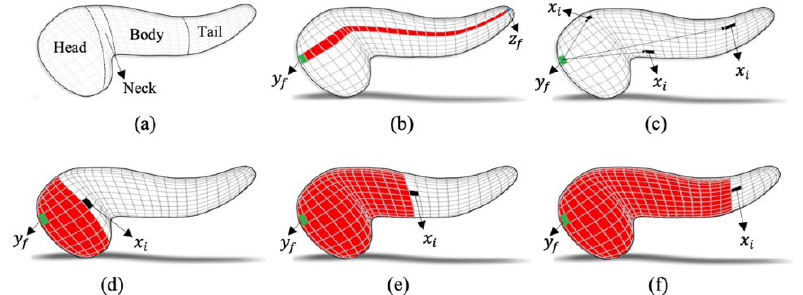
Figure 1. ( a ): Pancreas structure with head, neck, body, and tail region in a 3D mesh. ( b ): Length of the pancreas is shown as the shortest Euclidian distance (in red) between y f (in green) and the pixel farthest from it (in blue). ( c ): three examples of pixel x i (in black). For each x i , the α is the Euclidian distance between y f and x i . ( d – f ): Examples of x i considered at three different locations. For each x i , the β is the area (in red) between y f and x i in 3D